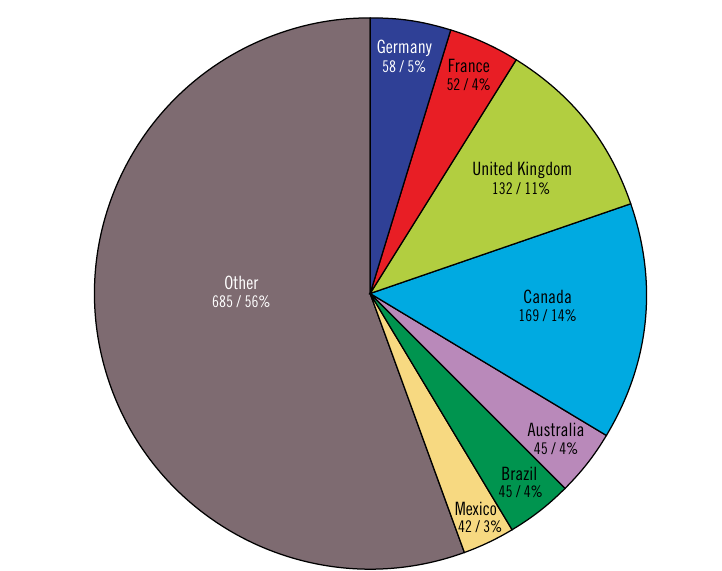
Table 5 – Countries Dominated by Japanese TNCs 1998 (IND 100) Figure 4 – Location of TNC Subsidiaries 1962